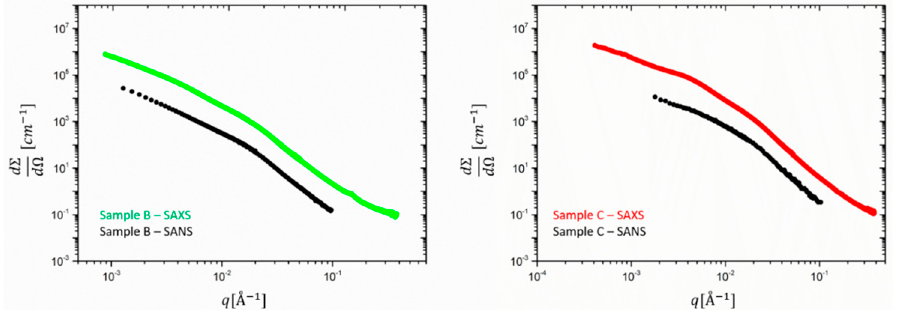
Figure 3. Experimental SANS and SAXS data in absolute intensity units cm − 1 for the ZnO-containing filled rubbers, sample B (left) and sample C(right). The number of data points of the ultrahigh-resolution SAXS data was about 4500 and was reduced to a SANS-compatible lower resolution of about 350 data points by means of a cubic spline fitting procedure.